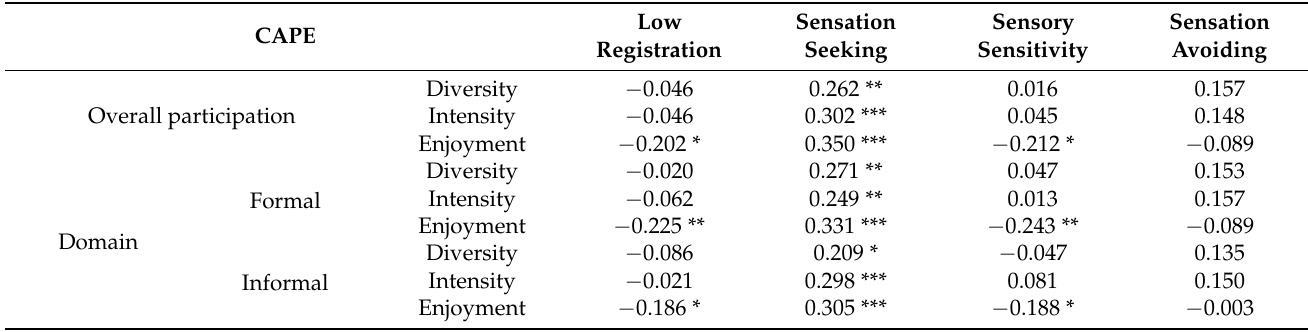
Table 2. Correlation matrix between AASP scores and